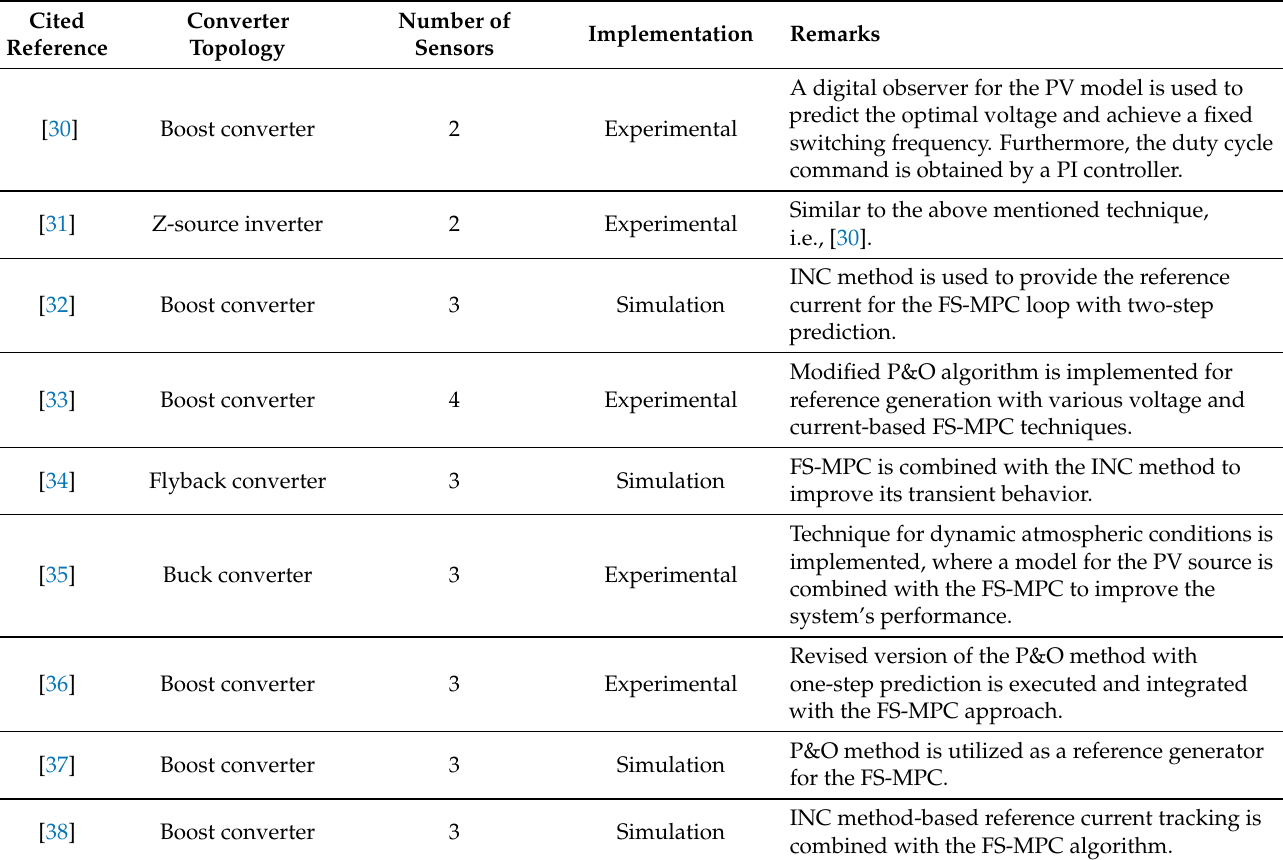
Table 1. Previous works on MPPT-based MPC.